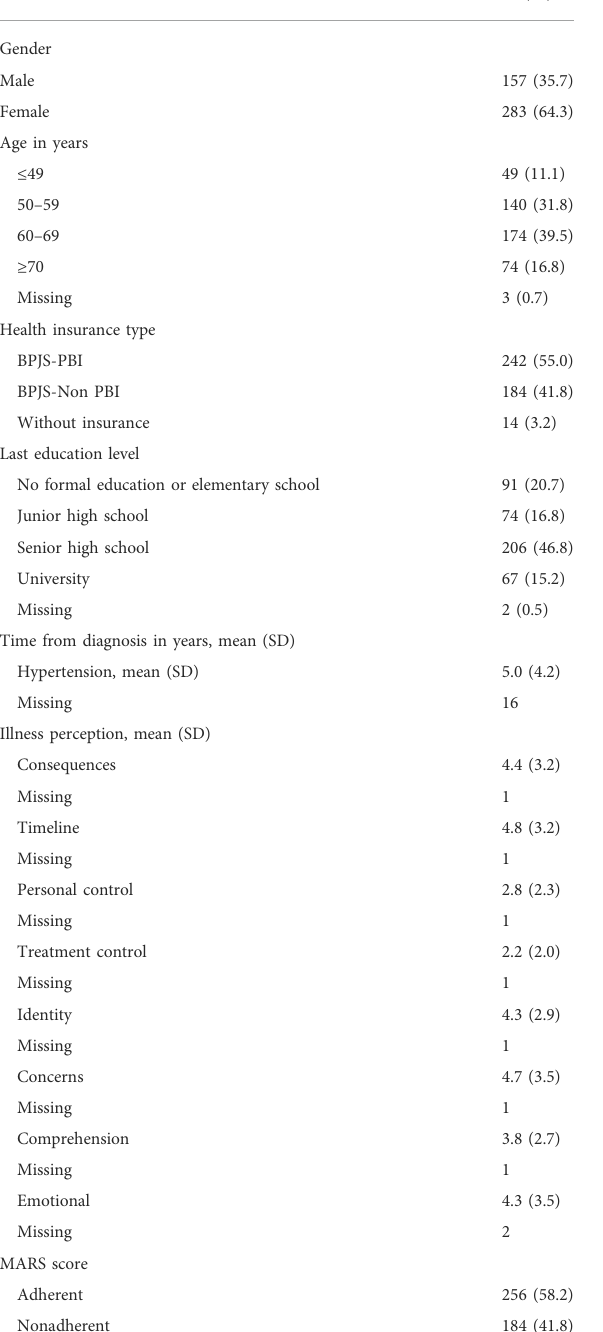
TABLE 1 Characteristics of patients (N = 440). TABLE 2Associationsbetween different domains ofillness perception and medication